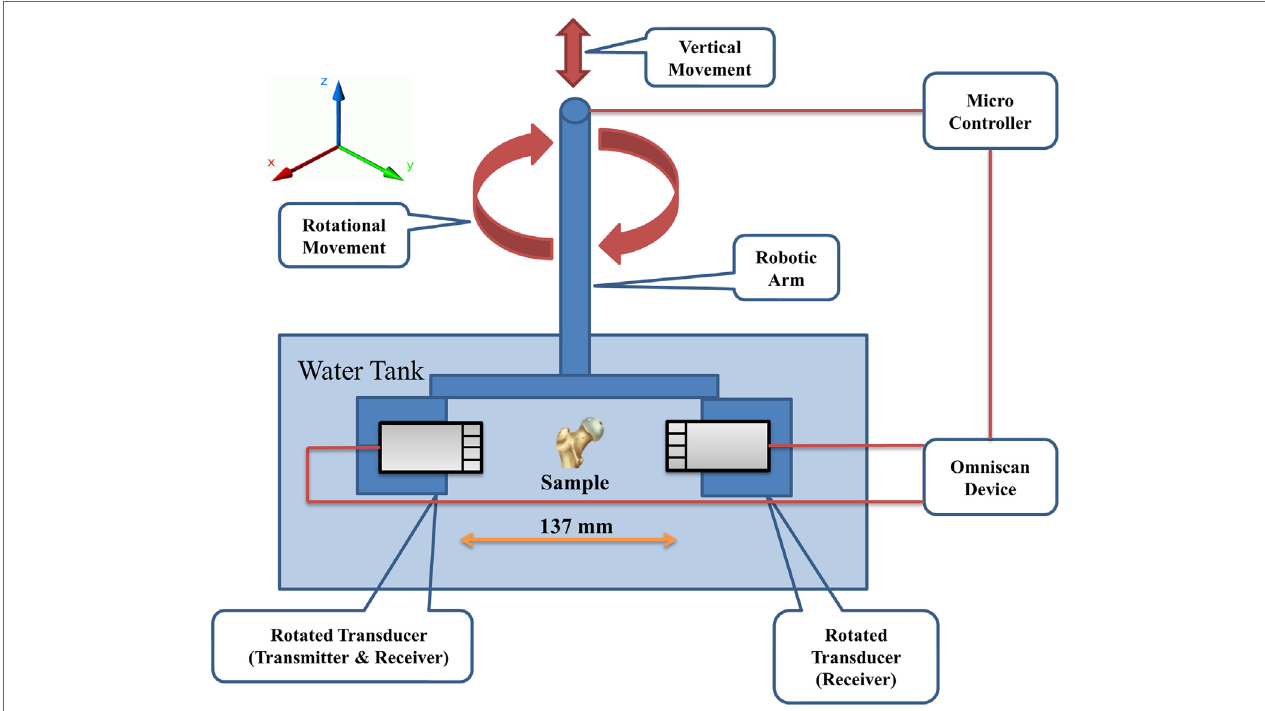
FigUre 1 | Schematic representation of the UCT system. The robotic arm is used to position the transducers such that the sample is approximately centered between the transducers in the xy -plane and positioned at the correct z -position for imaging. The robotic arm also rotates the transducers during acquisition. UCT, ultrasound computed